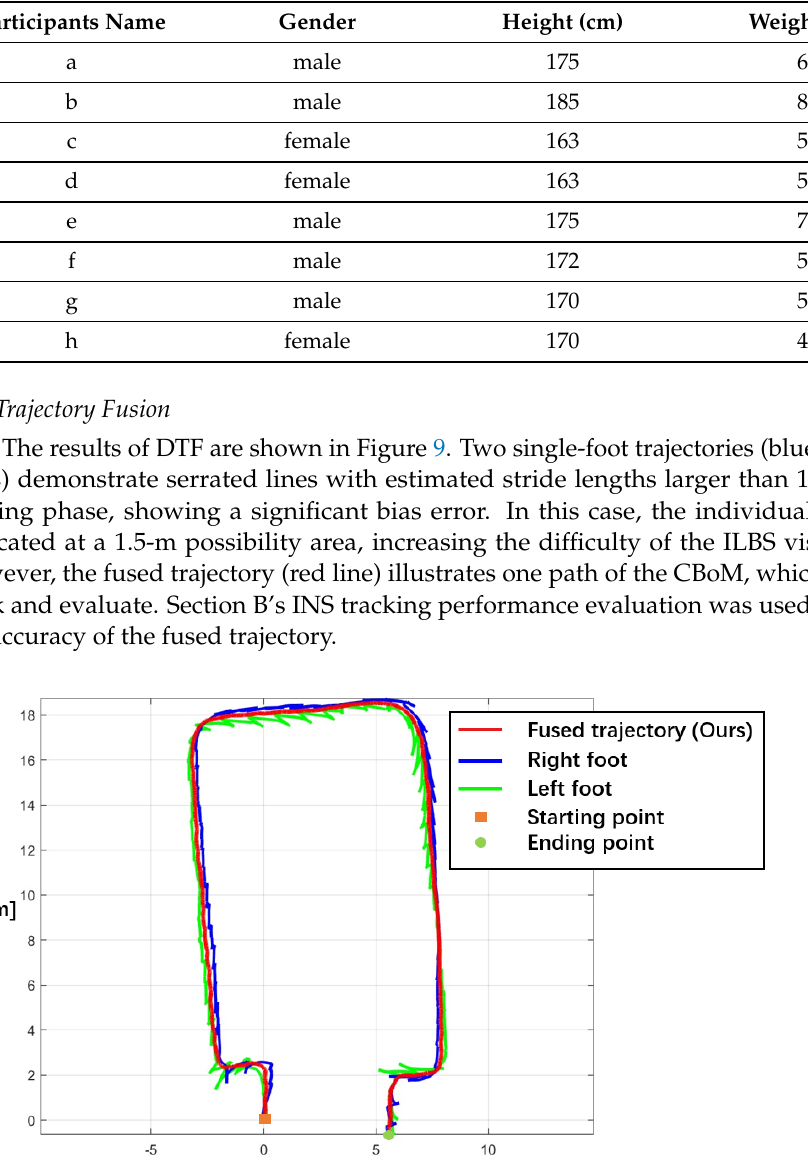
Table 3. Height and Weight Information of Volenteers.